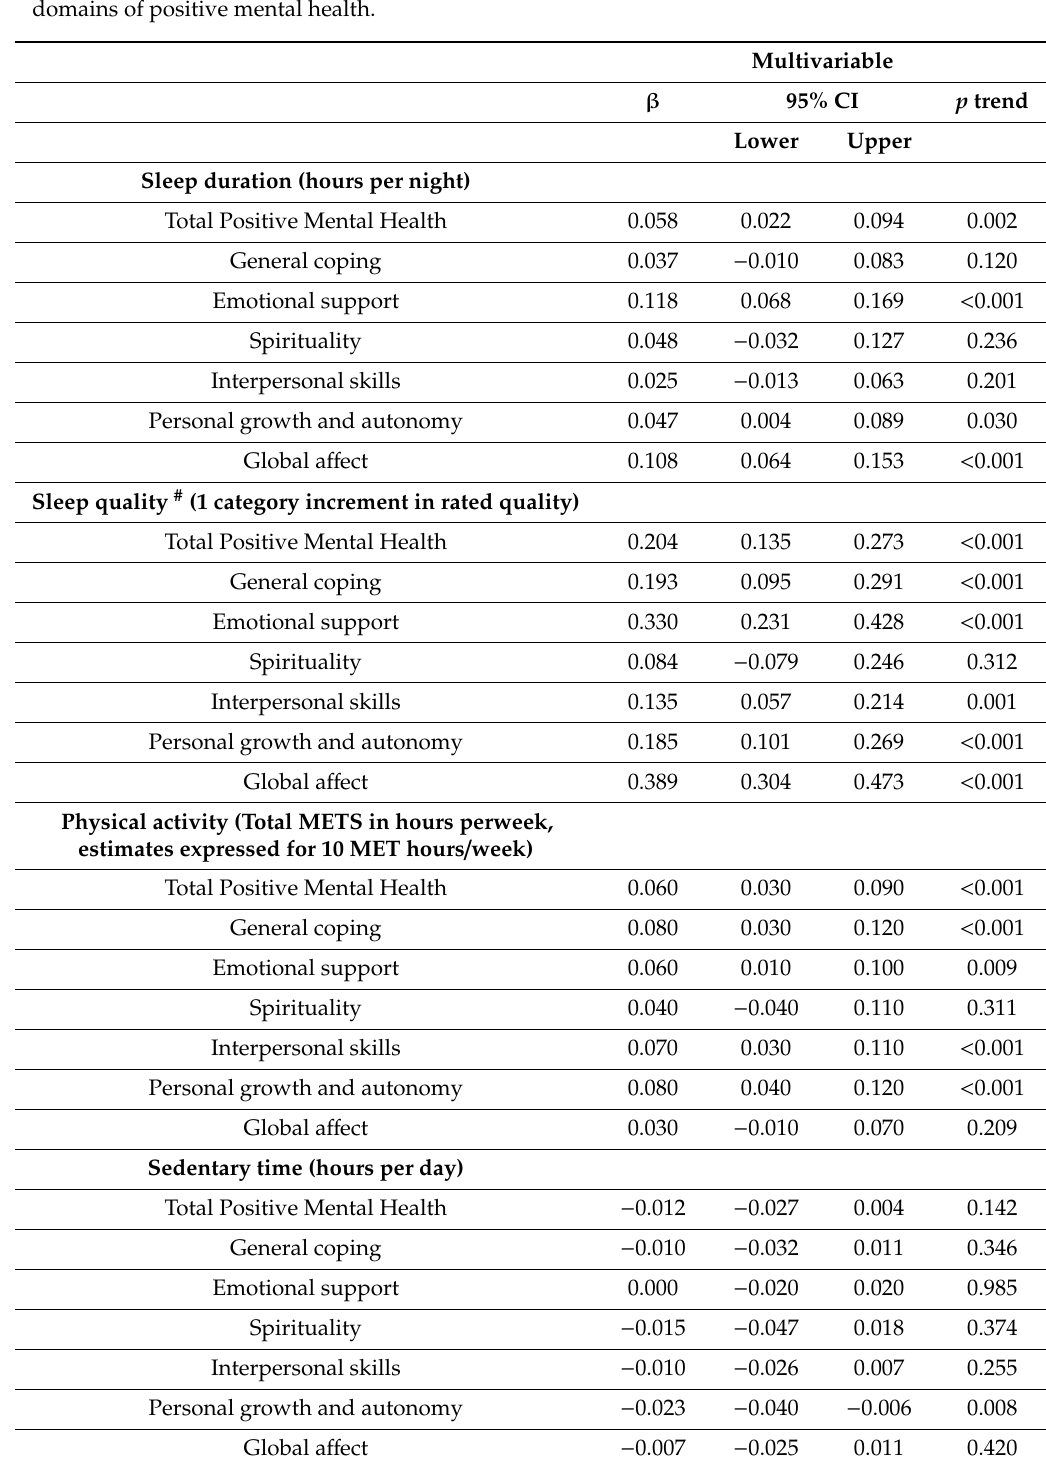
Table 3. Associations of sleep duration, sleep quality, physical activity and sedentary time with di ff erent domains of positive mental